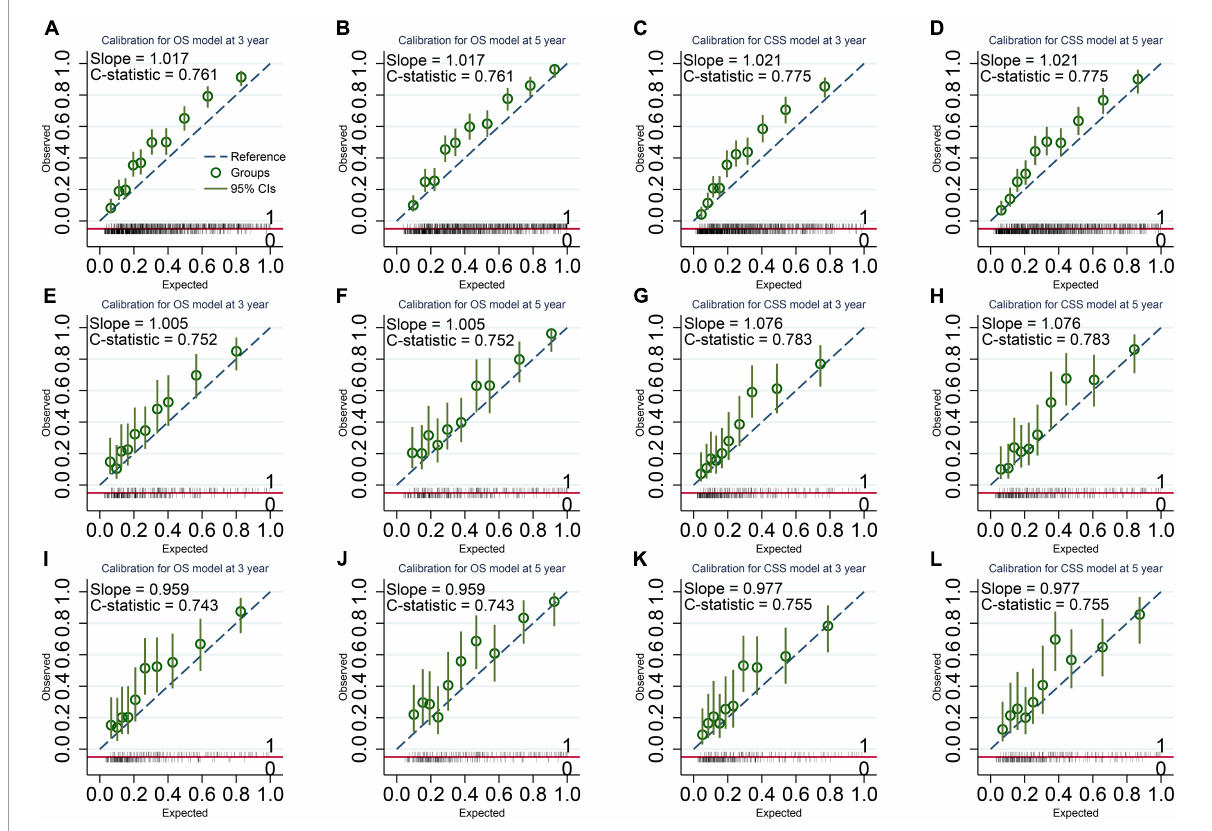
FIGURE3 Calibration Plots of the final overall survival (OS) and cancer-specific survival (CSS) models. (A,B) OS model in the imputed training cohort with a C-statistic of 0.761 and a slope of 1.017. (C,D) CSS model in the imputed training cohort with a C-statistic of 0.775 and a slope of 1.021. (E,F) OS model in the complete cases of the validation cohort with a C-statistic of 0.752 and a slope of 1.005. (G,H) CSS model in the complete cases of the validation cohort with a C-statistic of 0.783 and a slope of 1.076. (I,J) OS model in the imputed validation cohort with a C-statistic of 0.743 and a slope of 0.959. (K,L) CSS model in the imputed validation cohort with a C-statistic of 0.755 and a slope of 0.977. The calibration plots show a good agreement between the expected outcome predicted by our model and the observed